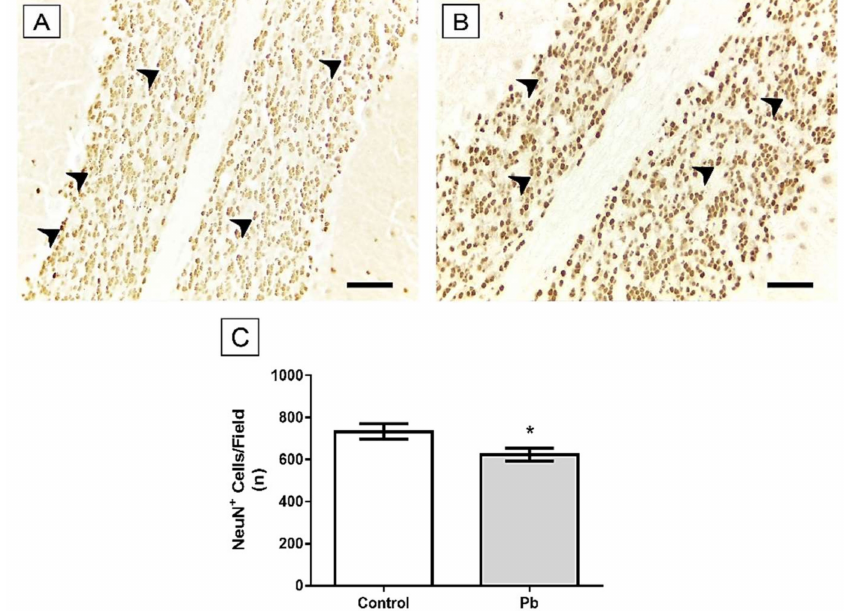
Figure 5. E ff ects of long-term exposure to Pb in the NeuN + cells (arrowhead) in cerebellum of Wistar rats. Representative photomicrographs of the ( A ) Control group and ( B ) Lead group. Results are expressed as mean ± standard error of ( C ) NeuN + cells density. * p < 0.05 compared to control group (Student’s t-test). Scale bars: 20 µ m.